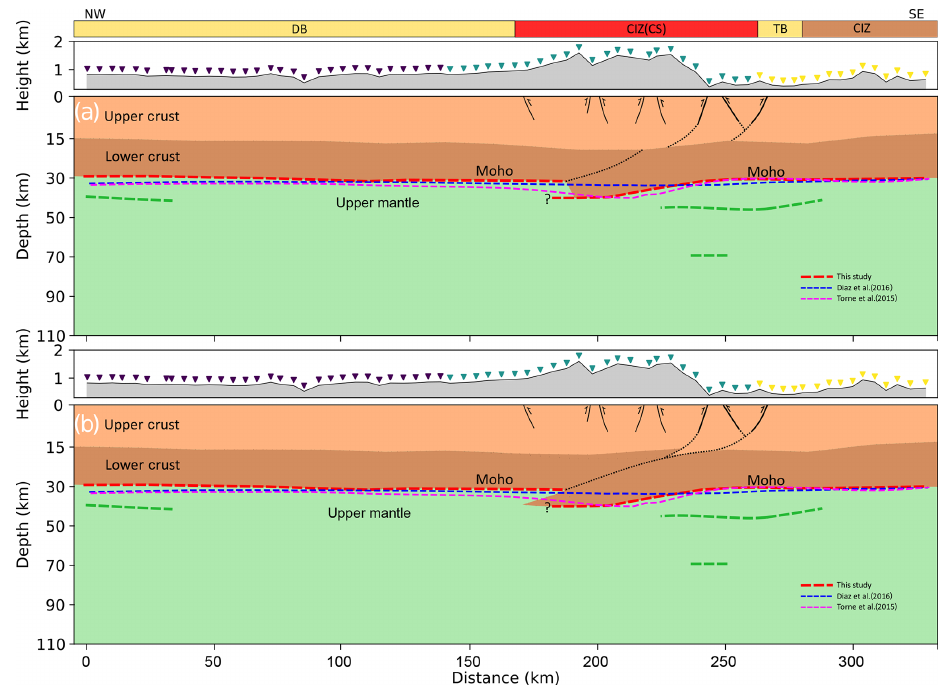
Figure 6. Sketch of the proposed crustal geometry, overlapped with Moho results from gravity inversion and receiver function (RF). (a) Model where the S thrust and the Tiétar fault lie within the upper crust and only the lower crust imbricates; (b) model where the entire crust imbricates below the